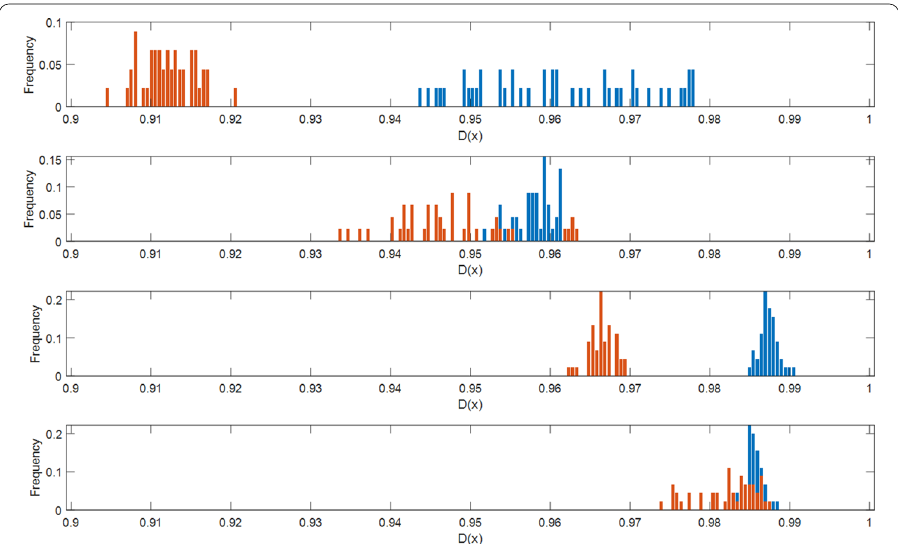
Fig. 4 D ( x ) of some pairs of recognized devices (blue bars) and rogue devices (red bars). The distribution of D ( x ) of some devices is shown in this figure. The blue bar in each sub-figure represents a recognized device and the red bar represents a rogue device for comparison. The abscissa indicates the value of D ( x ) and the ordinate indicates the frequency of occurrence of each value. The data is collected in a 30dB environment and the discriminator is trained for 5 epochs. The recognized and rogue devices were randomly selected from 54